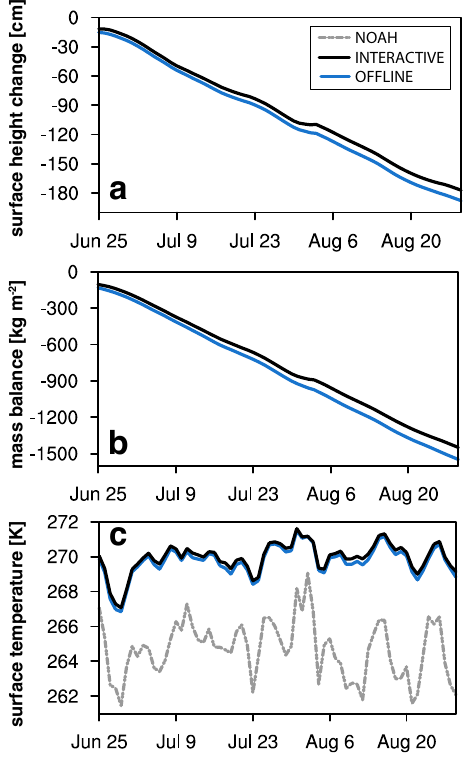
Fig. 7. Daily basin-scale averages of (a) accumulated surface height change, (b) accumulated total mass balance, and (c) surface tem- perature. Black (blue) curves display data from the interactive (of- fline) simulation. For reference, surface temperature simulated by the Noah LSM is the dashed grey curve in (c) .